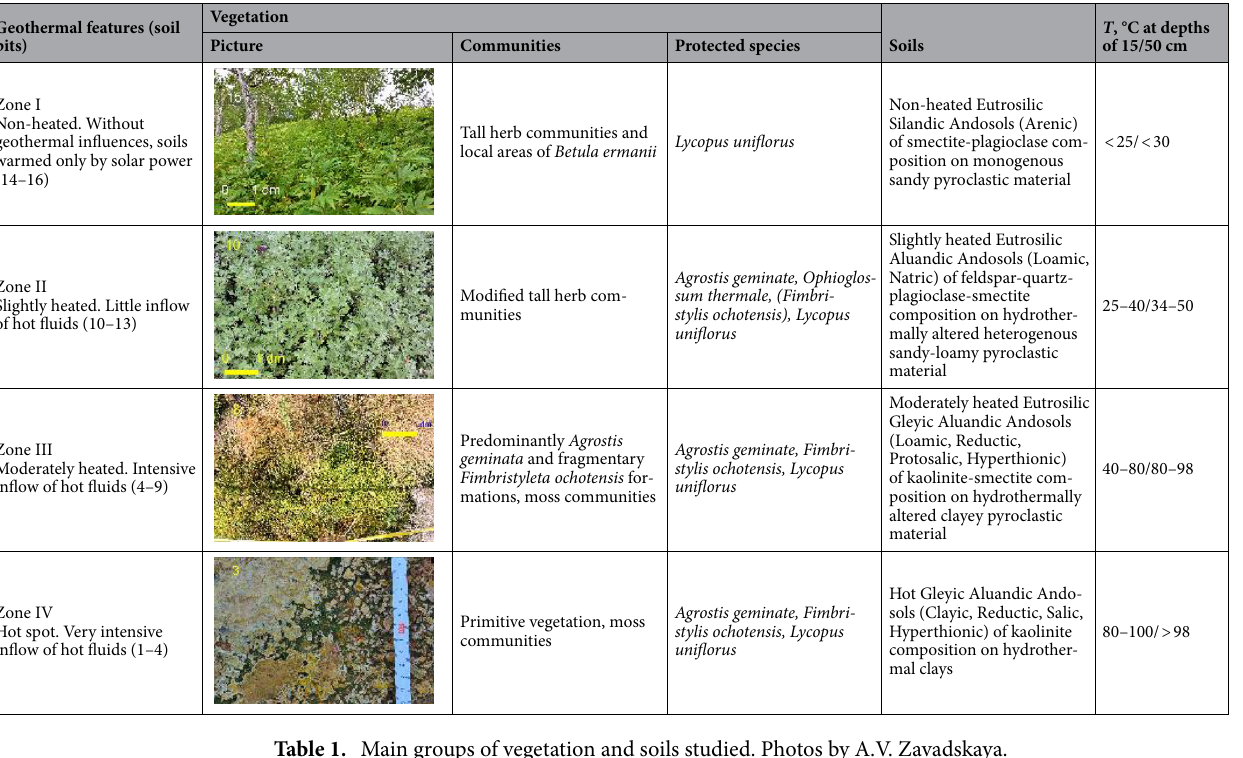
Table 1. Main groups of vegetation and soils studied. Photos by A.V. Zavadskaya.